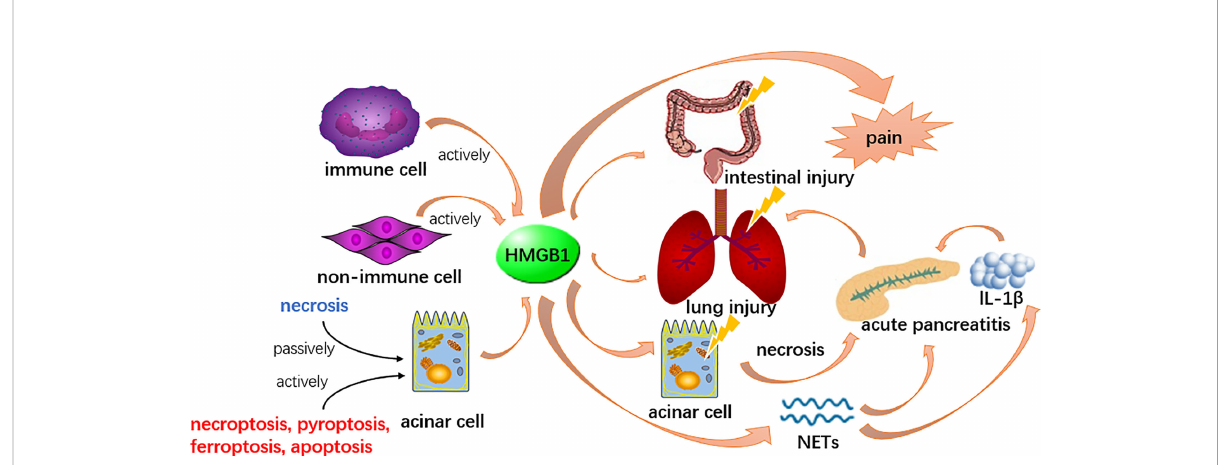
FIGURE 1 HMGB1 could be released by acinar cells and other cells in both active and passive ways. It participates in the formation of NETs and induce other acinar cell necrosis to boost the in fl ammation, therefore enhance the pathological process of AP. Meanwhile, HMGB1 is involved in lung and intestinal injury secondary to AP and serves as a pain